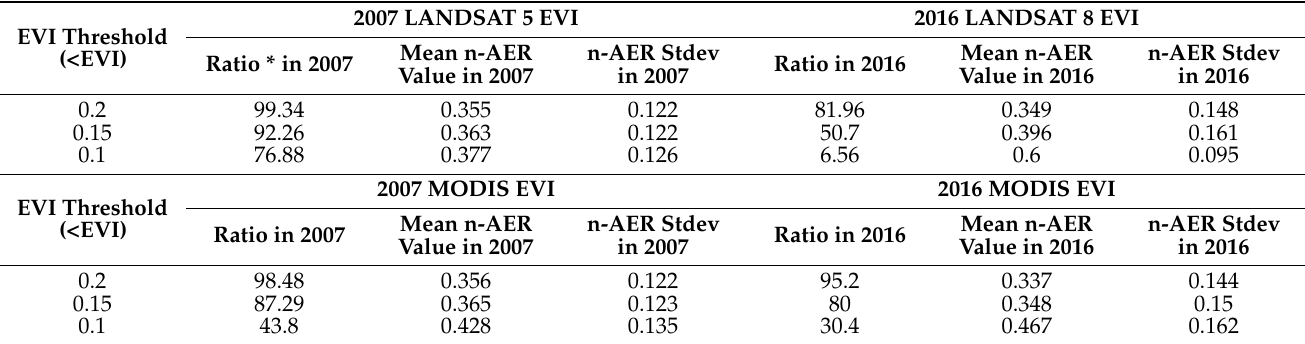
Figure 12. n-AER maps using Sentinel-1 in 2016 ( a ), 2017 ( b ), 2018 ( c ), 2019 ( d ), and 2020 ( e ). See the dotted ellipses where n-AER successfully detects the effect of ground compaction around solar panels. Note the range of n-AER is now adjusted between 0.0 to 1.0. Table 4. Distribution of low EVI areas and their n-AER